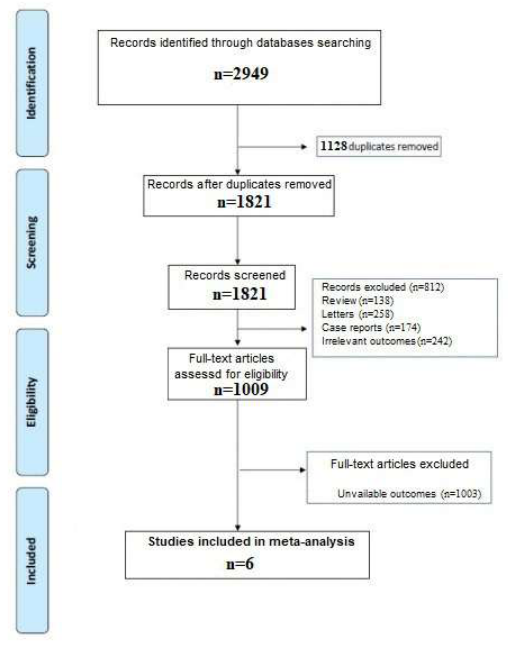
Figure 1. PRISMA flow diagram.